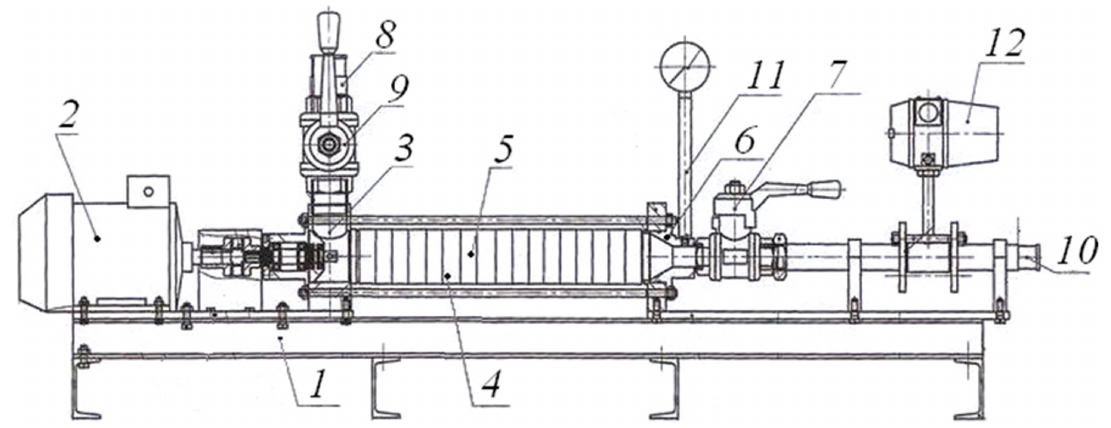
Figure 3. Test bench for operating stages of electric centrifugal pumps.